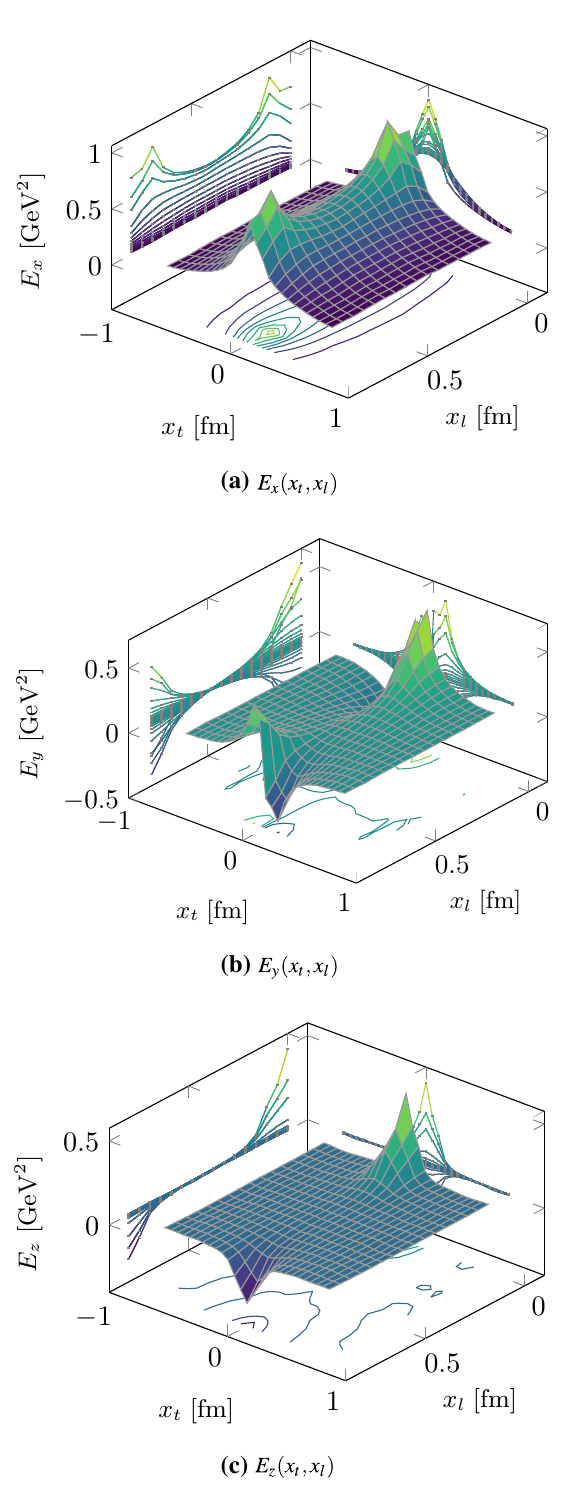
Fig. 2 Surface and contour plots for the three components of the chro- moelectric field at β = 6 . 370 and d = 0 . 85 fm. All plotted quantities are in physical units